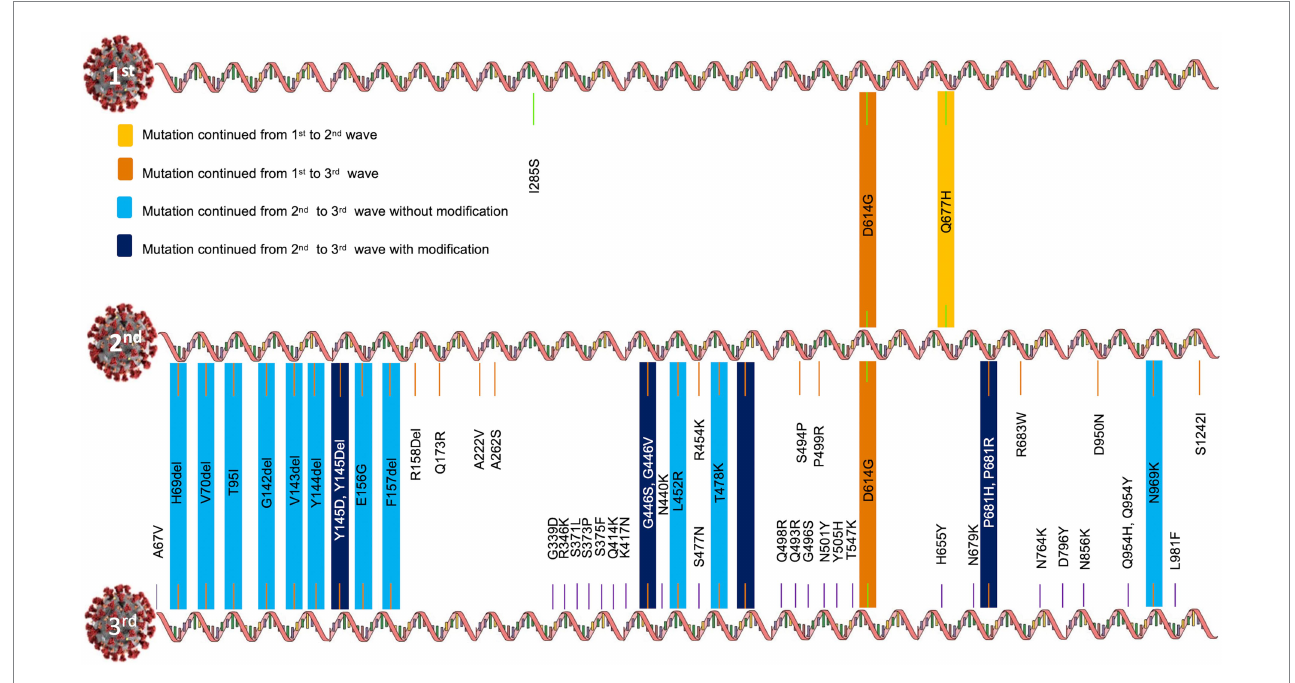
FIGURE 4 Evolution of Spike mutations during COVID-19 first to third waves in Uttar Pradesh, India.